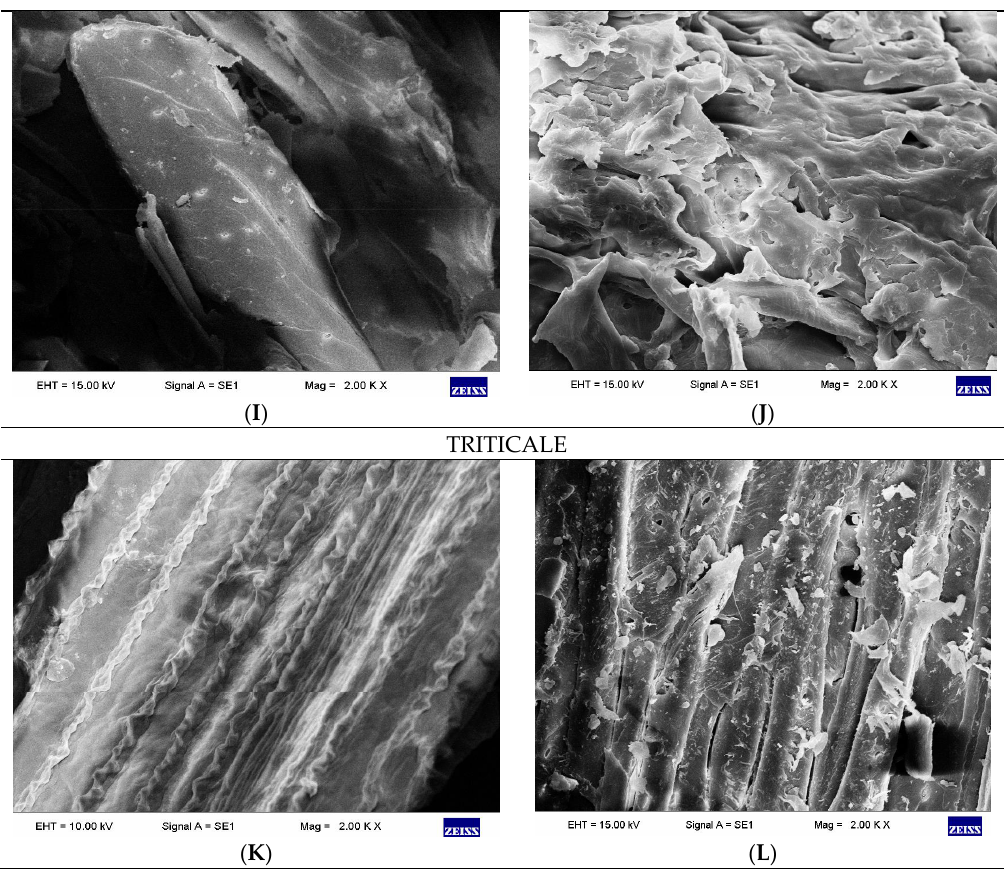
Figure 2. SEM images of investigated lignocellulosic materials, ( A ) Raw energetic willow; ( B ) MEA pre-treated energetic willow; ( C ) Raw beech; ( D ) MEA pre-treated beech; ( E ) Raw energetic poplar; ( F ) MEA pre-treated energetic poplar; ( G ) Raw meadow grass; ( H ) MEA pre-treated meadow grass; ( I ) Raw corn cobs; ( J ) MEA pre-treated corn cobs; ( K ) Raw triticale; ( L ) MEA pre-treated triticale.